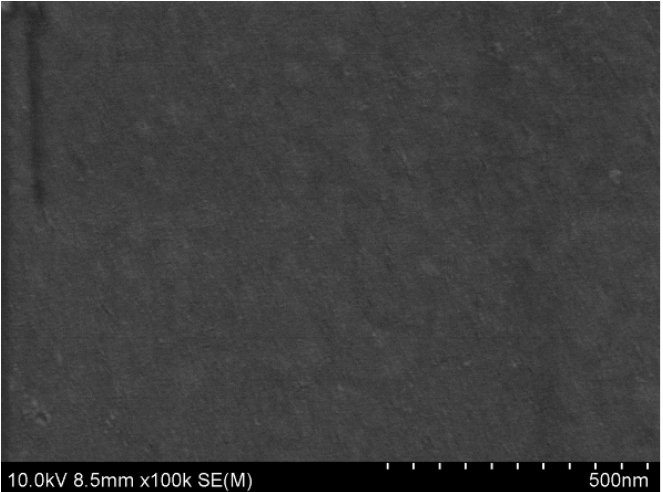
Figure 5. SEM surface morphology photos of the sample with thickness of 418 nm in Figure 3d.